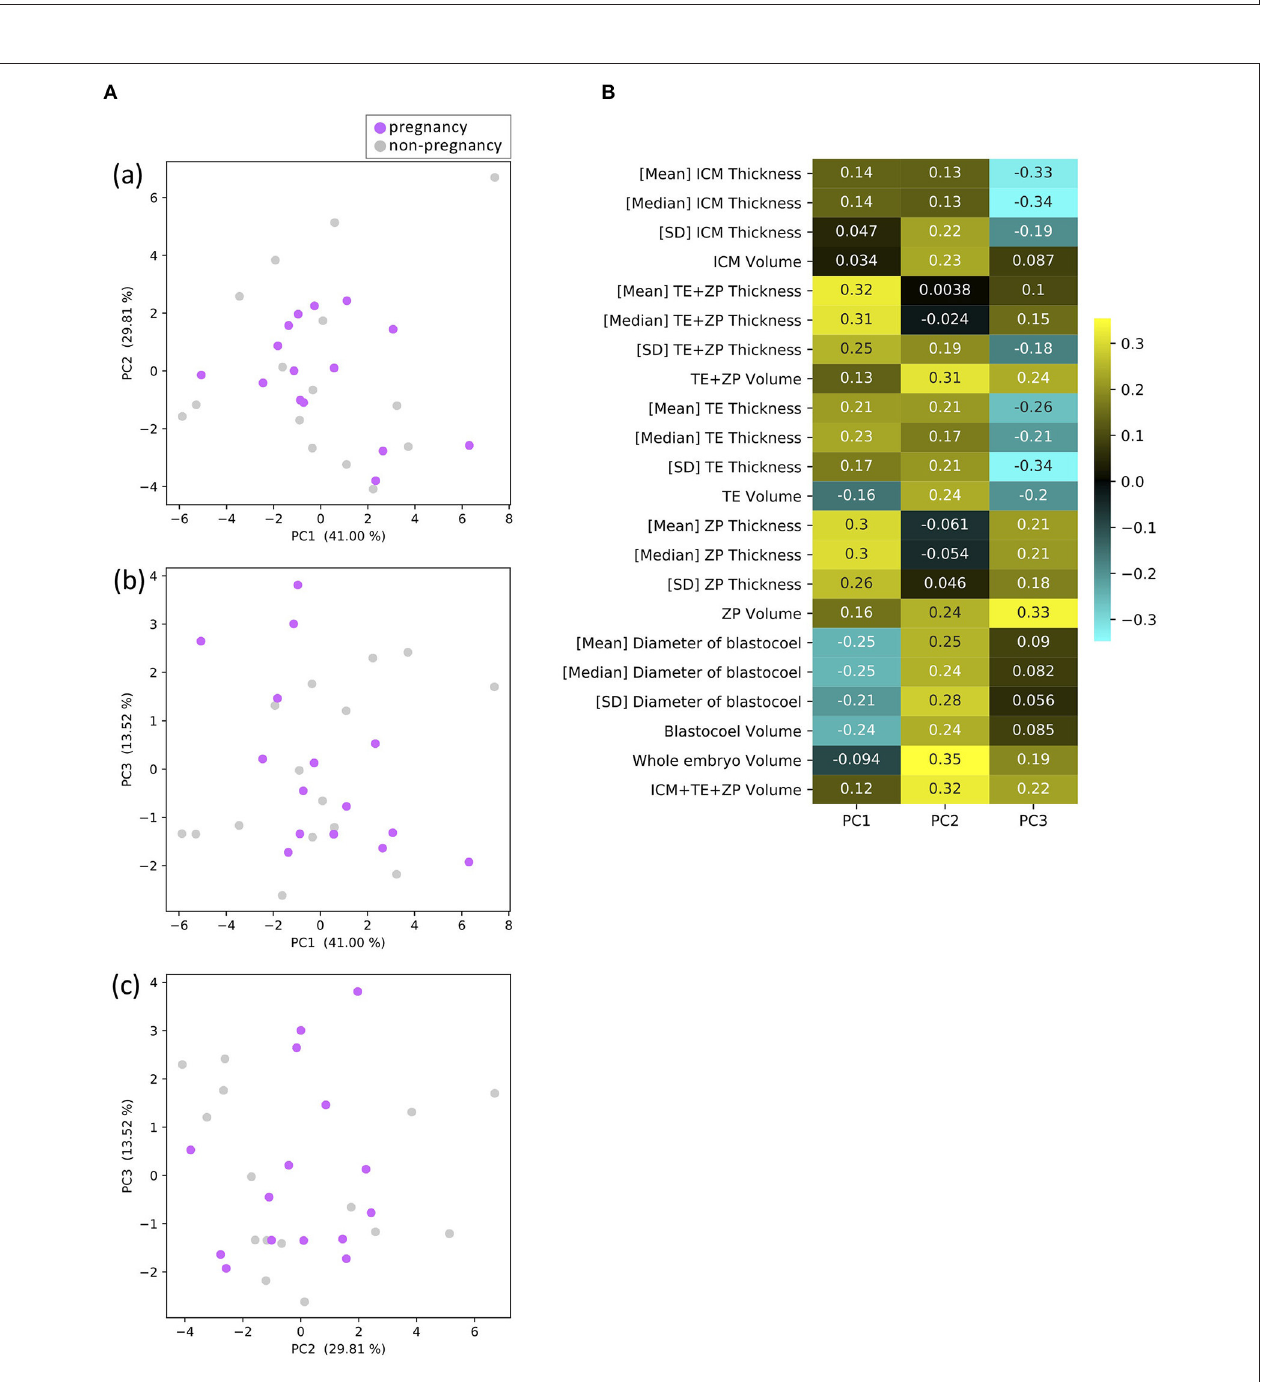
FIGURE 9 | Results of principal component analysis (PCA) based on the 22 morphological parameters of bovine blastocysts (pregnancy: n = 15, non-pregnancy: n = 15). (A) Two-dimensional PCA plots [ (a) PC1–PC2, (b) PC1–PC3, (c) PC3–PC2] profiled based on the morphological parameters evaluated from the OCT-scanned 3D images of bovine blastocysts. Each purple and gray dot represents blastocyst resulting in pregnancy and non-pregnancy, respectively. (B) Eigenvectors for PC1, 2, and 3.